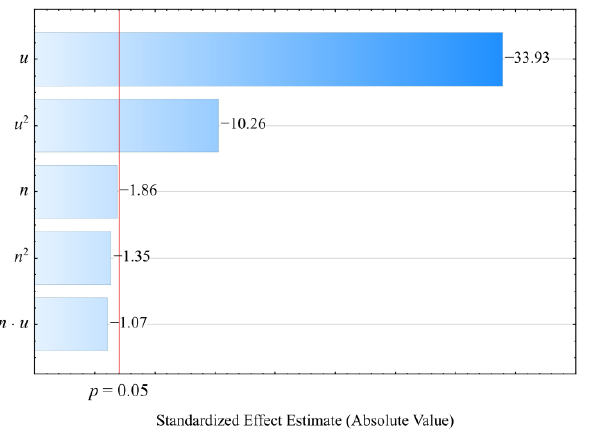
Figure 3. Pareto charts of the standardized effects for the empirical model of perpendicular shrinkage S P ; the vertical line in the plot corresponds to the arbitrarily chosen level of significance ( p = 0.05).